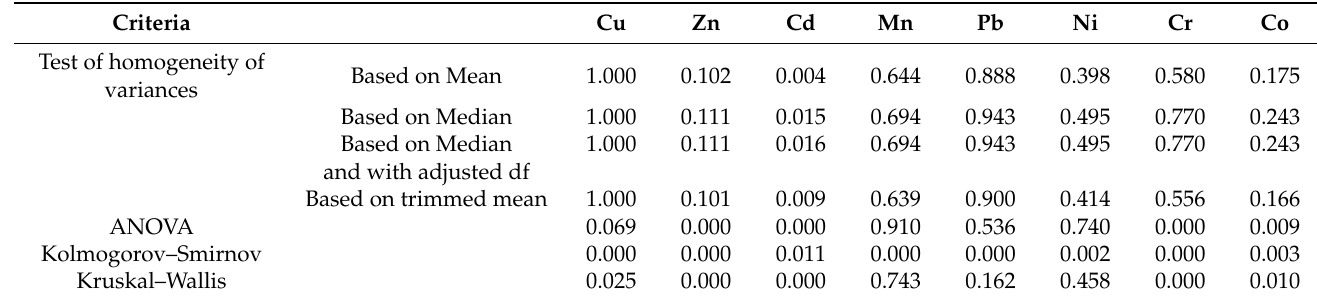
Table 5. Output of tests: Levene, ANOVA, Kolmogorov–Smirnov, and Kruskal–Wallis. The p -values are